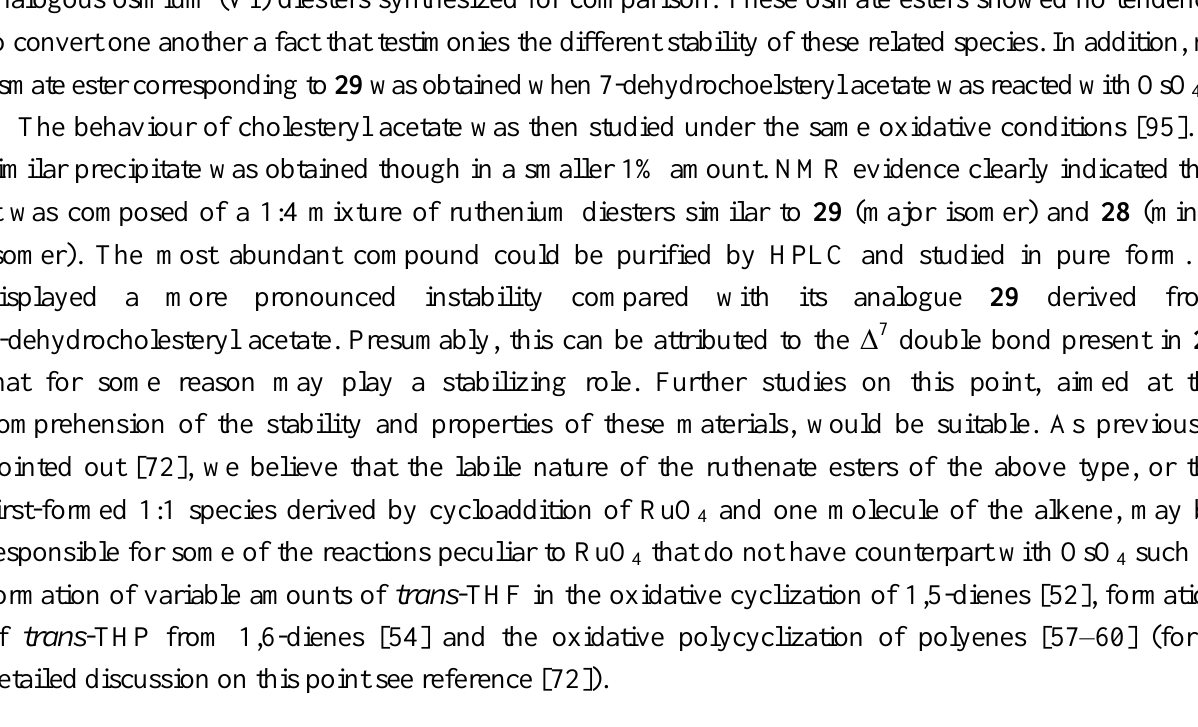
Scheme 20. Isomeric ruthenium(VI) diesters obtained by reaction of 7-dehydrocholesteryl acetate with RuO 4